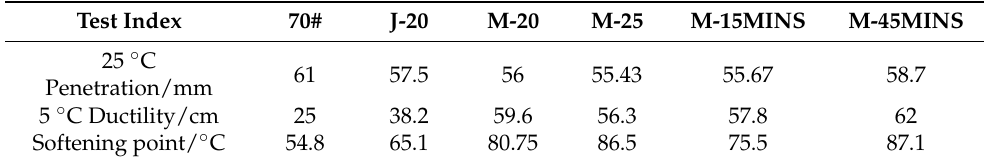
Table 2. Technical indexes of test samples.